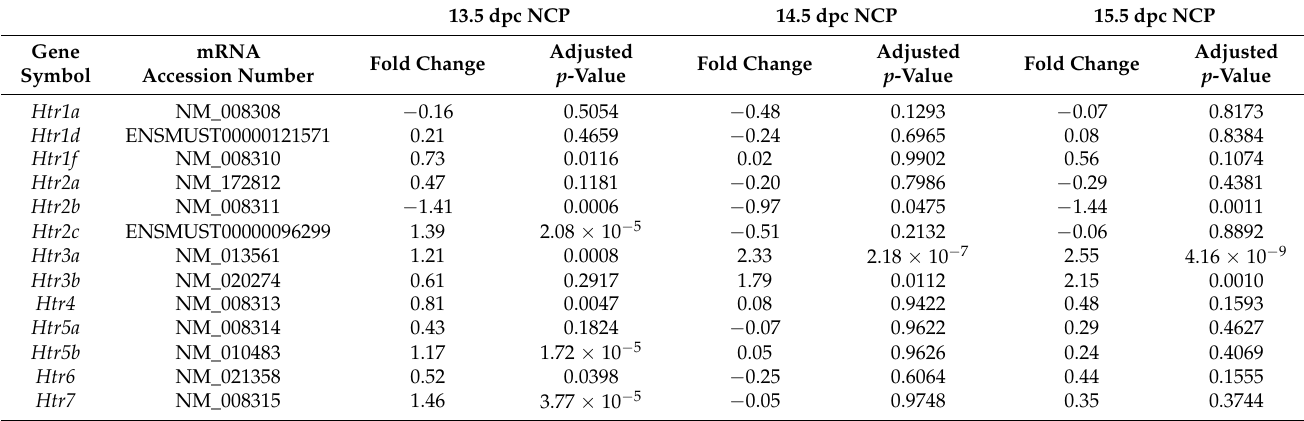
Table 1. Expression levels of 5-HT receptor genes in developing pelvic